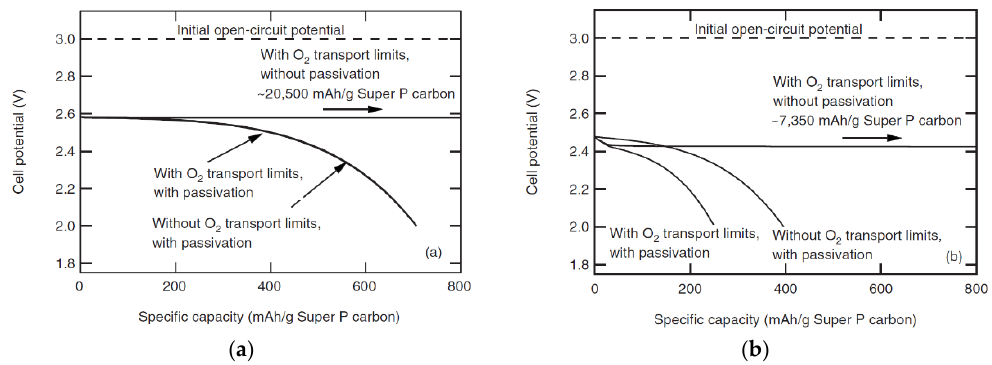
Figure 6. Simulation results demonstrating the relative impacts of oxygen transport limitation and electronic resistance of the discharge products. Load condition: ( a ) 0.08 mA/cm 2 ; ( b ) 0.46 mA/cm 2 . Republished from Albertus et al. [9] with permission of Electrochemical Society, conveyed through Copyright Clearance Center, Inc.